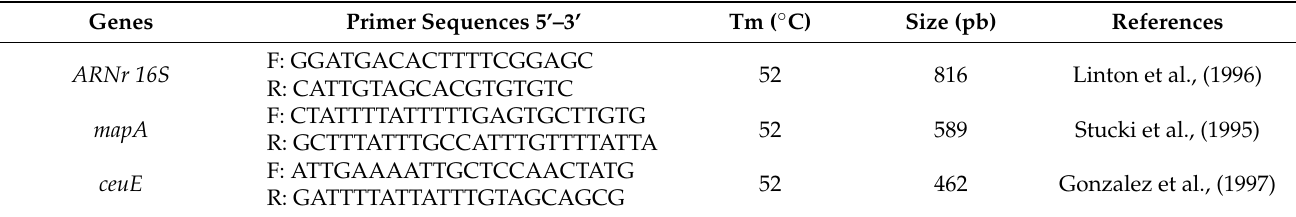
Table 1. Primer sequences used for Campylobacter spp. identification and expected amplicon sizes. Genes Primer Sequences